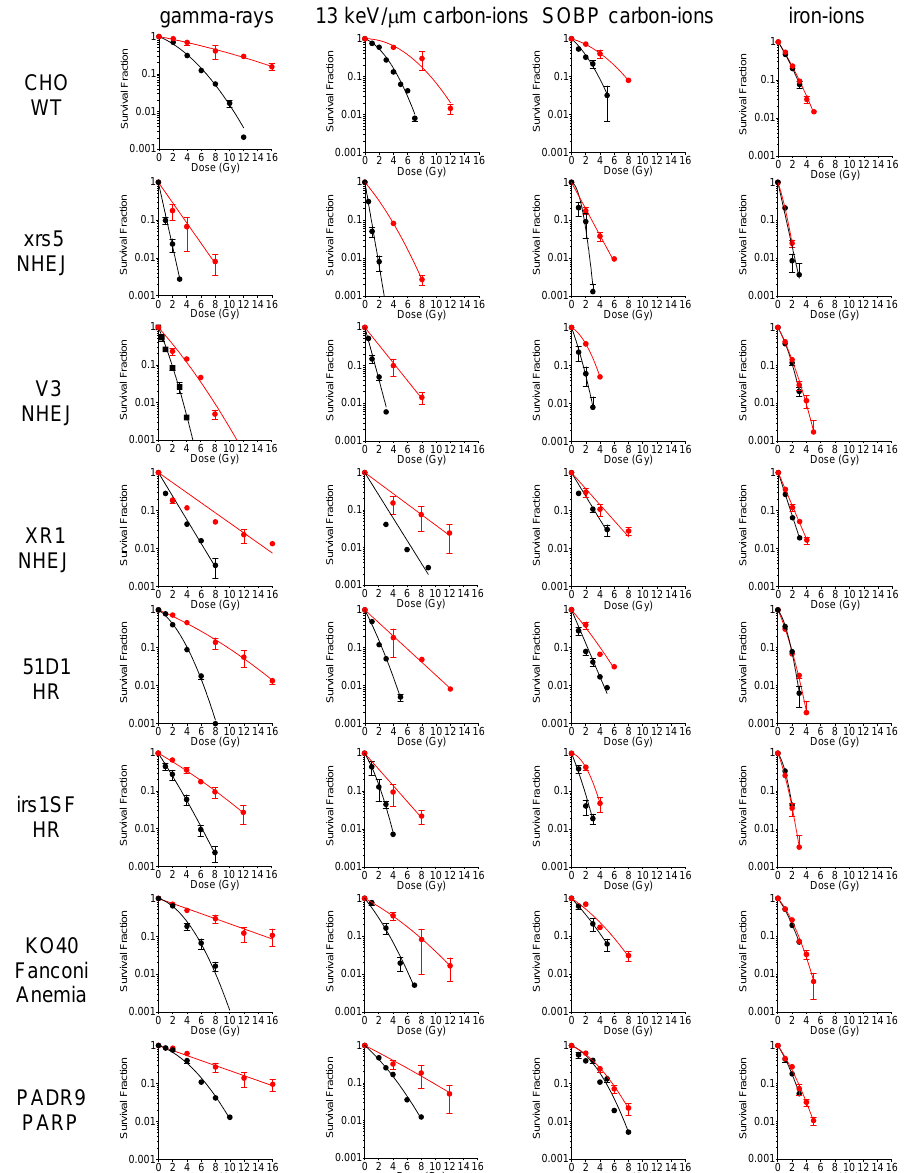
Figure 1. Cell survival curves generated for gamma-rays, carbon ion, carbon ion SOBP (Spread Out Bragg Peak), and iron ions irradiation under aerobic and hypoxic conditions. Black circles indicate the aerobic condition and red circles indicate the hypoxic condition. Error bars represent the standard error of the means. At least three independent experiments were carried out.